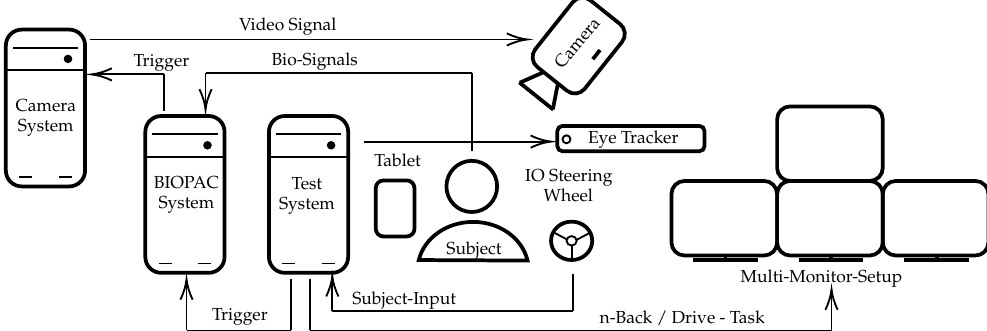
Figure 3. System components used during both experiments. Synchronization over multiple com- ponents mitigates effects such as clock drifts between different computer systems. The main test computer runs the experimentation software written in PsychoPy. The subject uses the buttons on a steering wheel as an input device during various experiments. The eye-tracker is synchronized with the main test computer. The camera system is triggered (on rising edge) with a constant low/high analog trigger signal having a frequency of 25 frames sent by the Biopac system. The camera is set to idle and automatically starts when the Biopac system is started at the beginning of the experiment and automatically stops as soon as the Biopac software stops. The Biopac system and the main test system are connected through a TTL line, sending the current state of the experiment at times of experiment phase transition as 255 bit-encoded signal, all interactions with buttons, as well as a continuous signal for